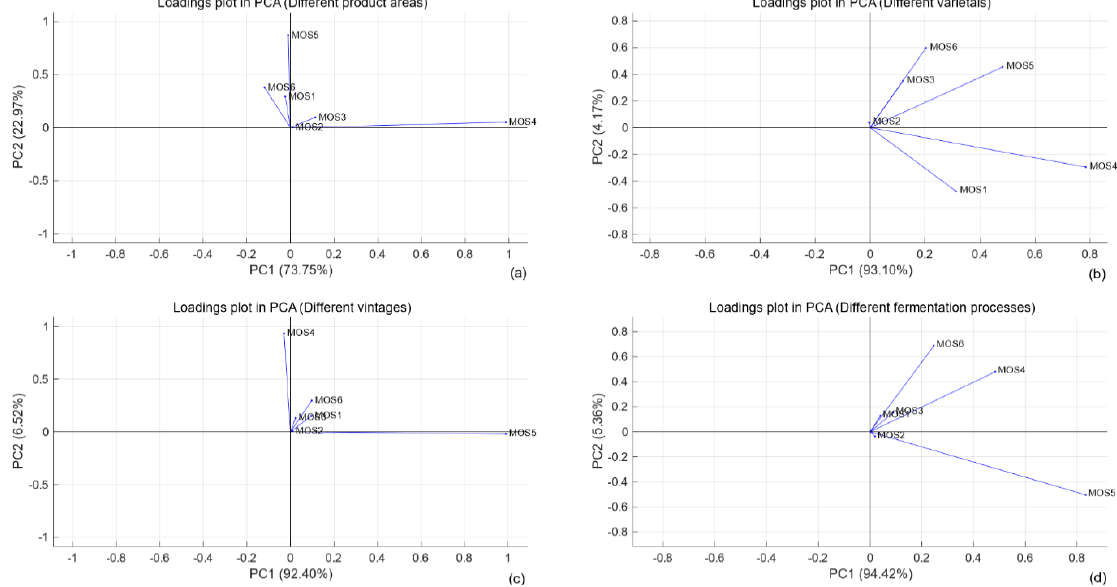
Figure 6. PCA loadings plots of different wine samples measurements (each kind of sample from the training lots were presented). ( a ) the samples with different product areas; ( b ) the samples with different varietals; ( c ) the samples with different vintages; ( d ) the samples with different fermentation processes.